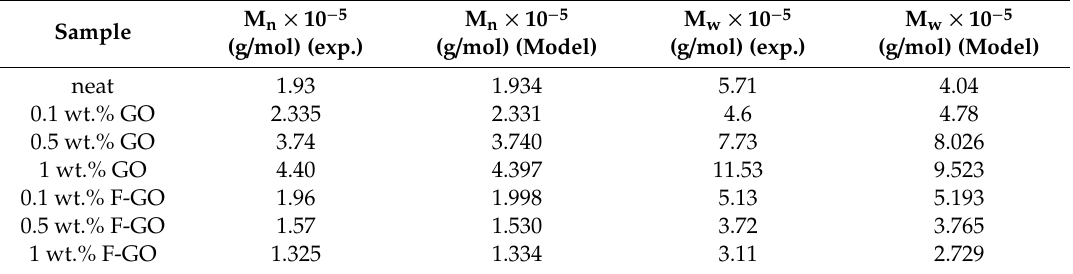
Table 3. Final Product Number Average Molecular Weight (M n ) and Weight Average Molecular Weight (M w ) for neat P(S- co -BMA) 20:80 copolymer and its nanocomposites.